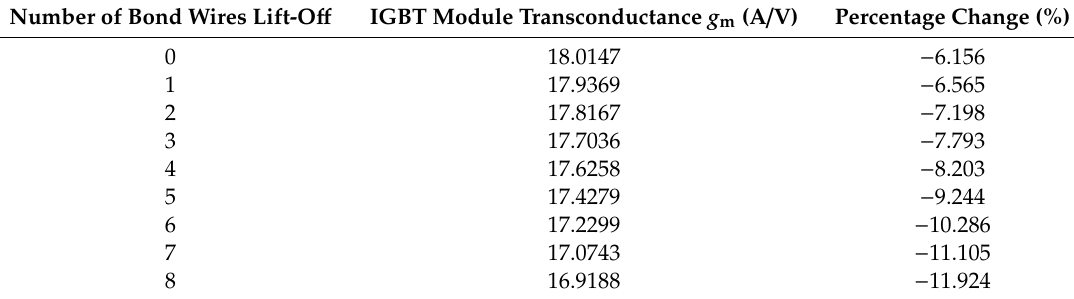
Figure 11. The transmission characteristic curve of Chip 2 under bond wire failure states. Table 8. Module transconductance of Chip 2 under bond wire failure states.